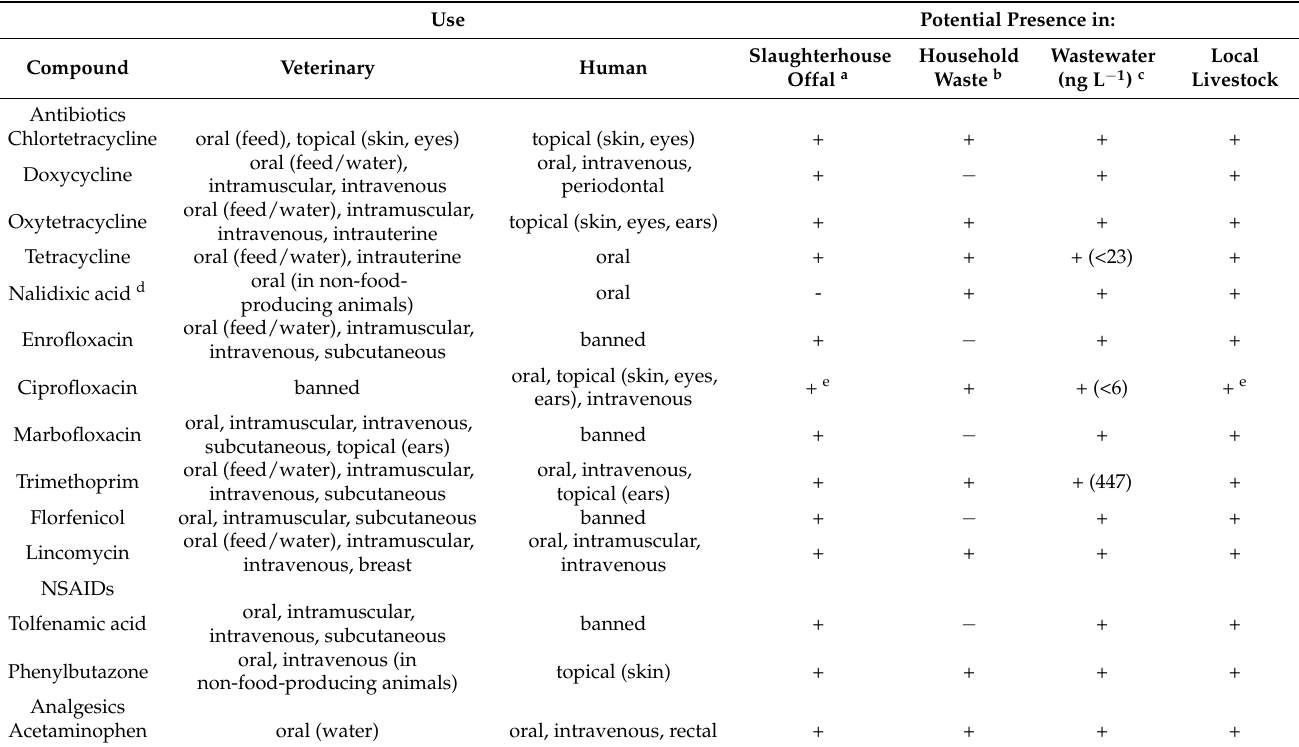
Table 1. Overview of use and potential sources of exposure to white stork nestlings in the study area. “+” refers to potential presence and “ − ” refers to potential lack of presence in each of the exposure sources